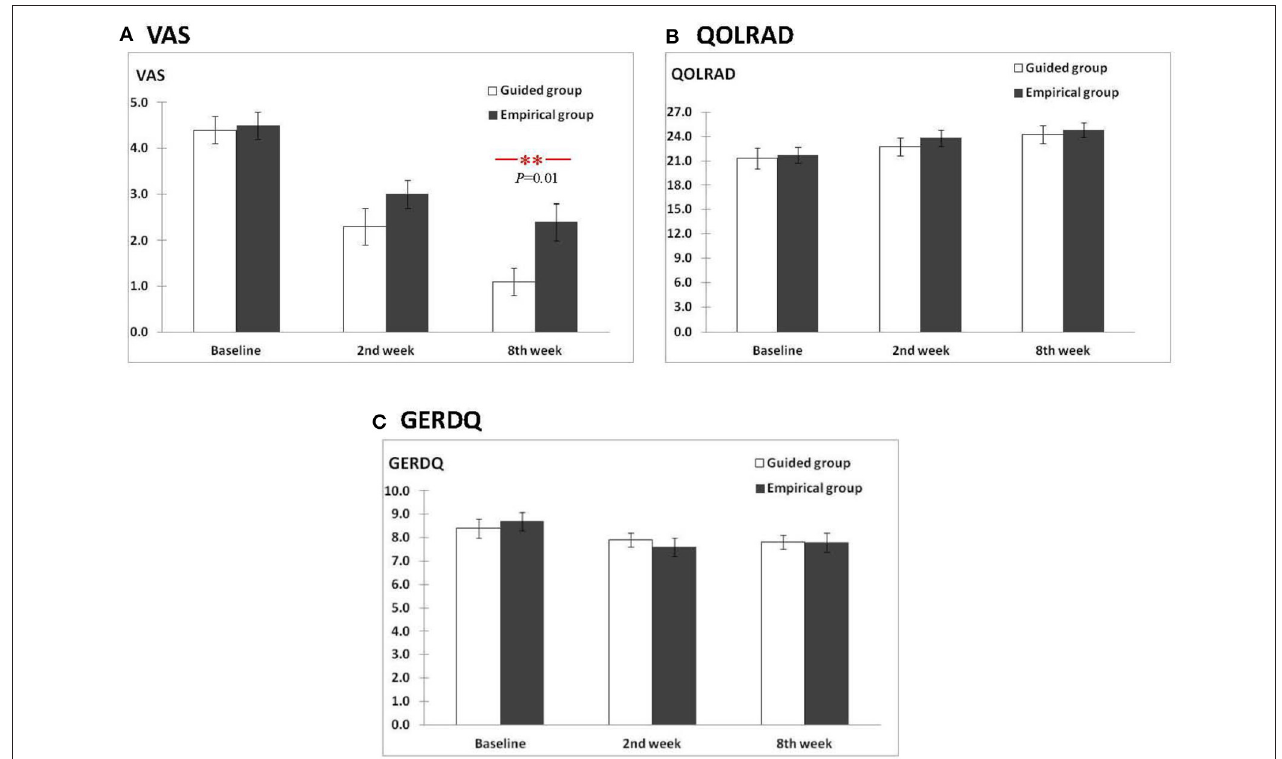
FIGURE 2 | Comparison of scores between the guided and empirical groups for (A) VAS, (B) QOLRAD, and (C) GERDQ.